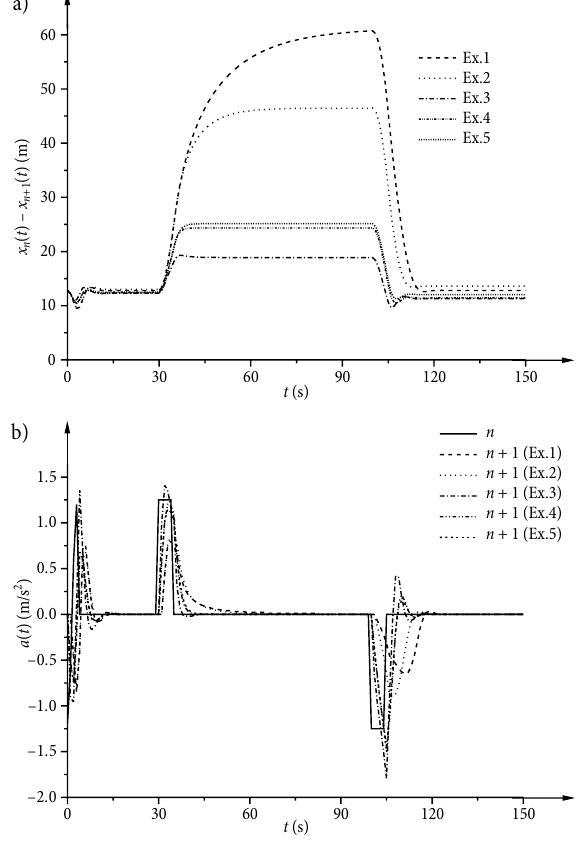
Fig. 3. A comparison of the new model (3) to the original model (1): a – profiles of the distance headways between the lead and following vehicles; b – acceleration